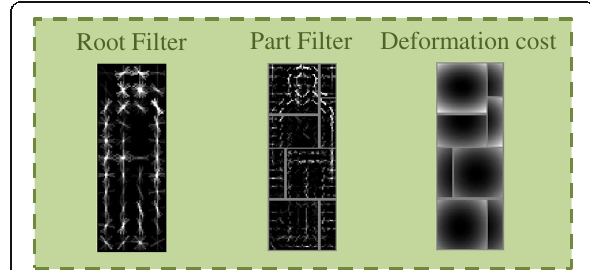
Fig. 7 Illustration of a pre-trained DPM. ( Left ) A coarse DPM root filter. ( Middle ) Several higher-resolution DPM part filters. ( Right ) Deformation cost associated with each DPM part filter [30]